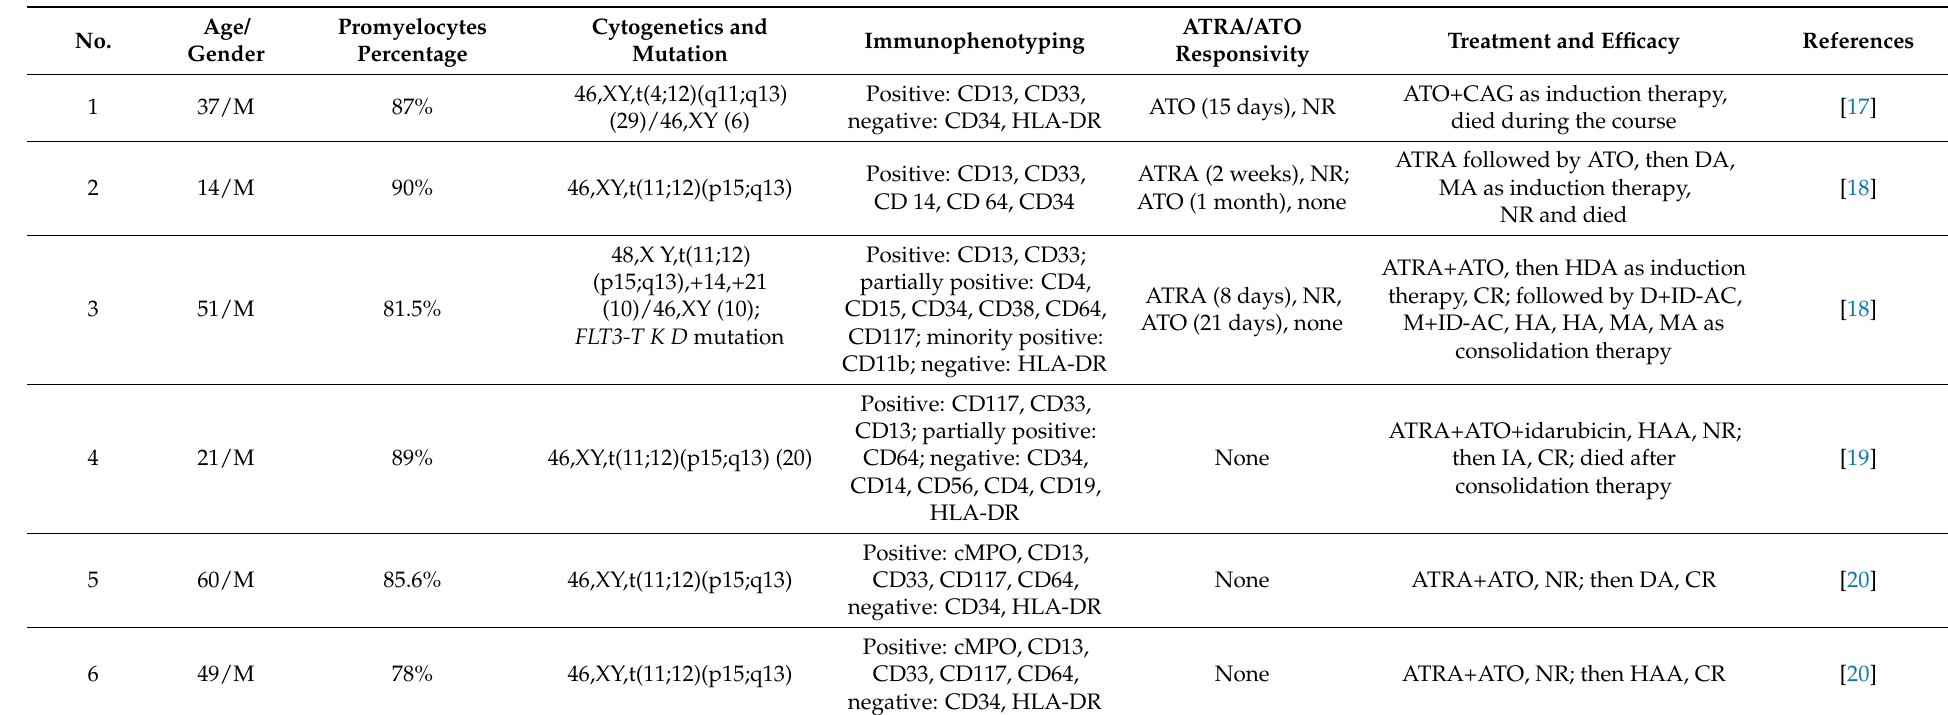
Table 3. Cases of APLL with 12q13 rearrangement and unidentified fusion